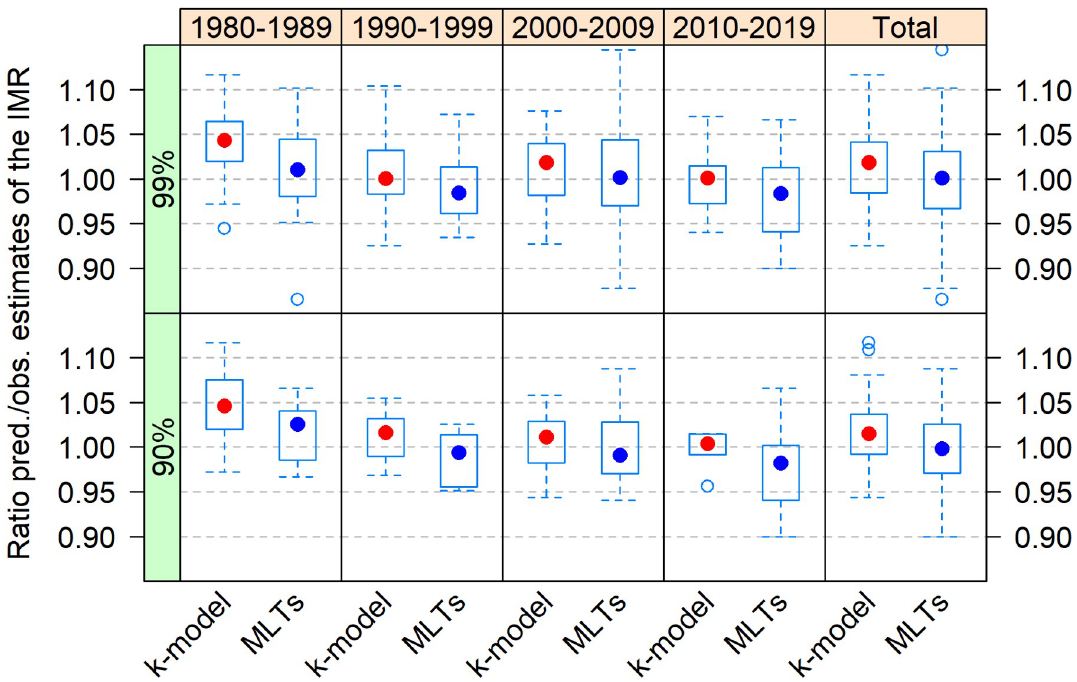
Fig 5. Predicted vs observed ratio of the IMR in individual DHS surveys by decade with predictions made using the k-model or MLTs.